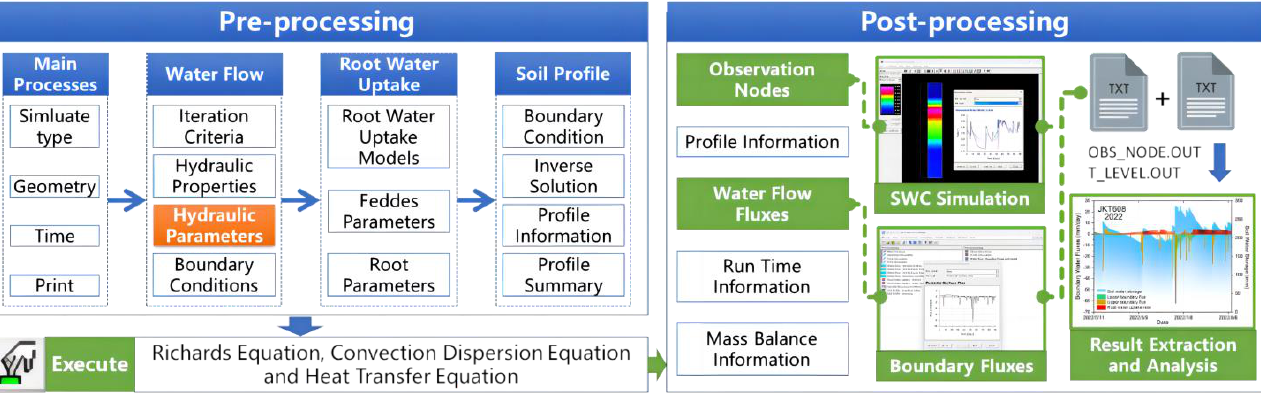
Figure 2. Overview of the Hydrus-1D model soil moisture simulation process.